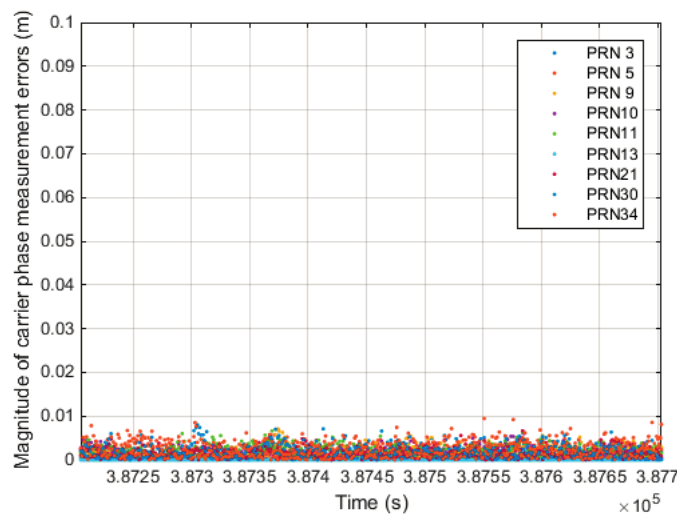
Figure 17. Magnitude of carrier phase measurement errors (static test).